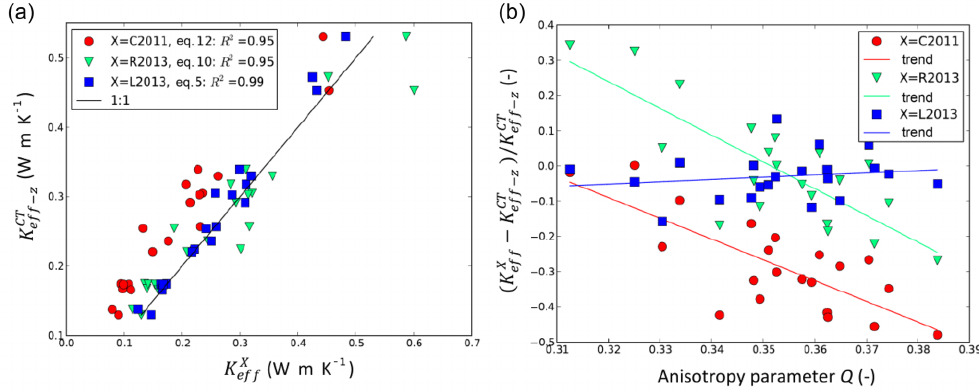
Figure 5. (a) Comparison between estimates of K eff or K eff − z made with the CT method ( K CT “ X ” ( K X , where X = C2011, R2013 or L2013: see paper for description of these parameterizations). (b) Relative bias in K X eff to K CT as a function of the anisotropy parameter Q . Each point represents a snow sample analysed by CT in this study. eff − z